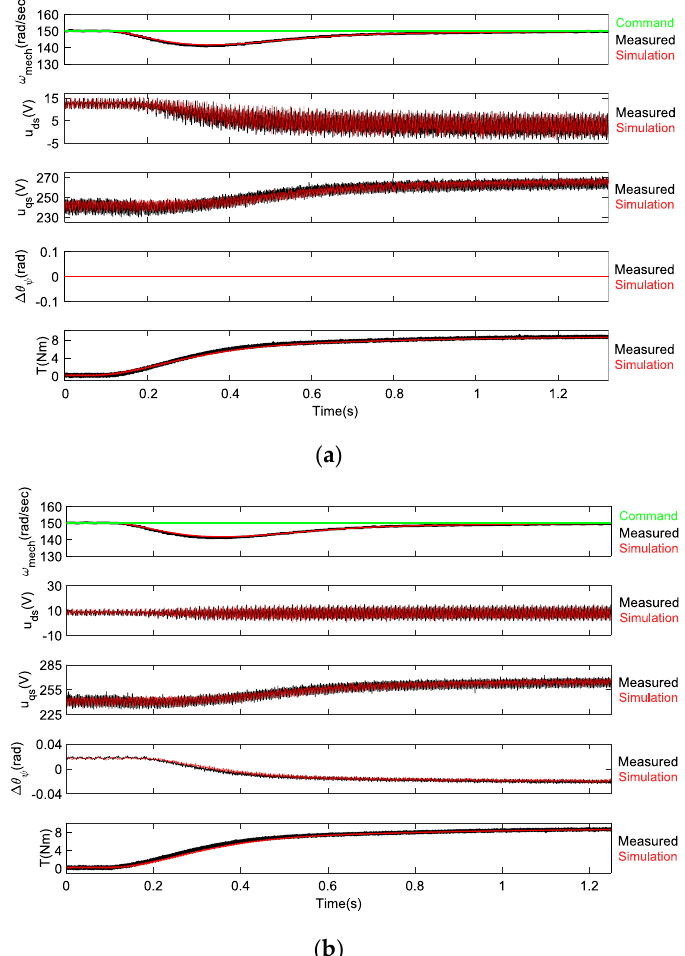
Figure 18. PI controller response for a step change in the load at constant speed: ( a ) without correction of θ ψ , ( b ) with correction of θ ψ .